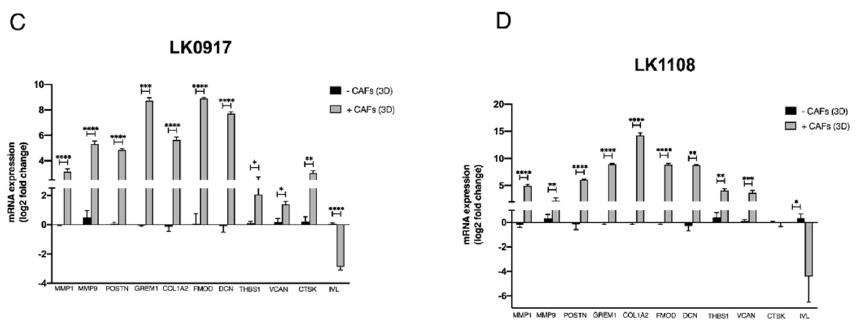
Figure 2. Verification of microarray with qRT-PCR. Five head and neck squamous cell carcinoma cell lines (LK0824, LK0858, LK0923, LK0942, LK0949) were grown alone or co-cultured with their patient-matched cancer-associated fibroblasts (CAFs) as 2D monolayers for 7 days. RNA was isolated from tumor cells (separated from CAFs by magnetic activated cell sorting) and the mRNA expression of the COL1A2, GREM1 , and POSTN genes, which, by microarray analysis, were identified as differentially expressed in co-cultures, was analyzed by qRT-PCR. The log 2 mRNA levels of co-cultured tumor cells are shown relative to the expression in tumor cells grown alone ( A ). Three head and neck squamous cell carcinoma cell lines were grown in spheroids alone or co-cultured with their patient-matched cancer-associated fibroblasts (CAFs) for 5 days. RNA was isolated from tumor cells (separated from CAFs by magnetic activated cell sorting) and the mRNA expression of the MMP1, MMP9, POSTN, GREM1, COL1A2, FMOD, DCN, THBS1, VCAN, CTSK , and IVL genes, which, by microarray analysis, were identified as differentially expressed in co-cultures, was analyzed by qRT-PCR. The log 2 mRNA levels of co-cultured tumor cells are shown relative to the expression in tumor cells grown alone ( B – D ). Data were normalized to cells cultured without CAFs for each gene (mean values ± SD; n = 3). * p ≤ 0.05, ** p ≤ 0.01, *** p ≤ 0.001, **** p ≤ 0.0001 according to Student’s t -test.